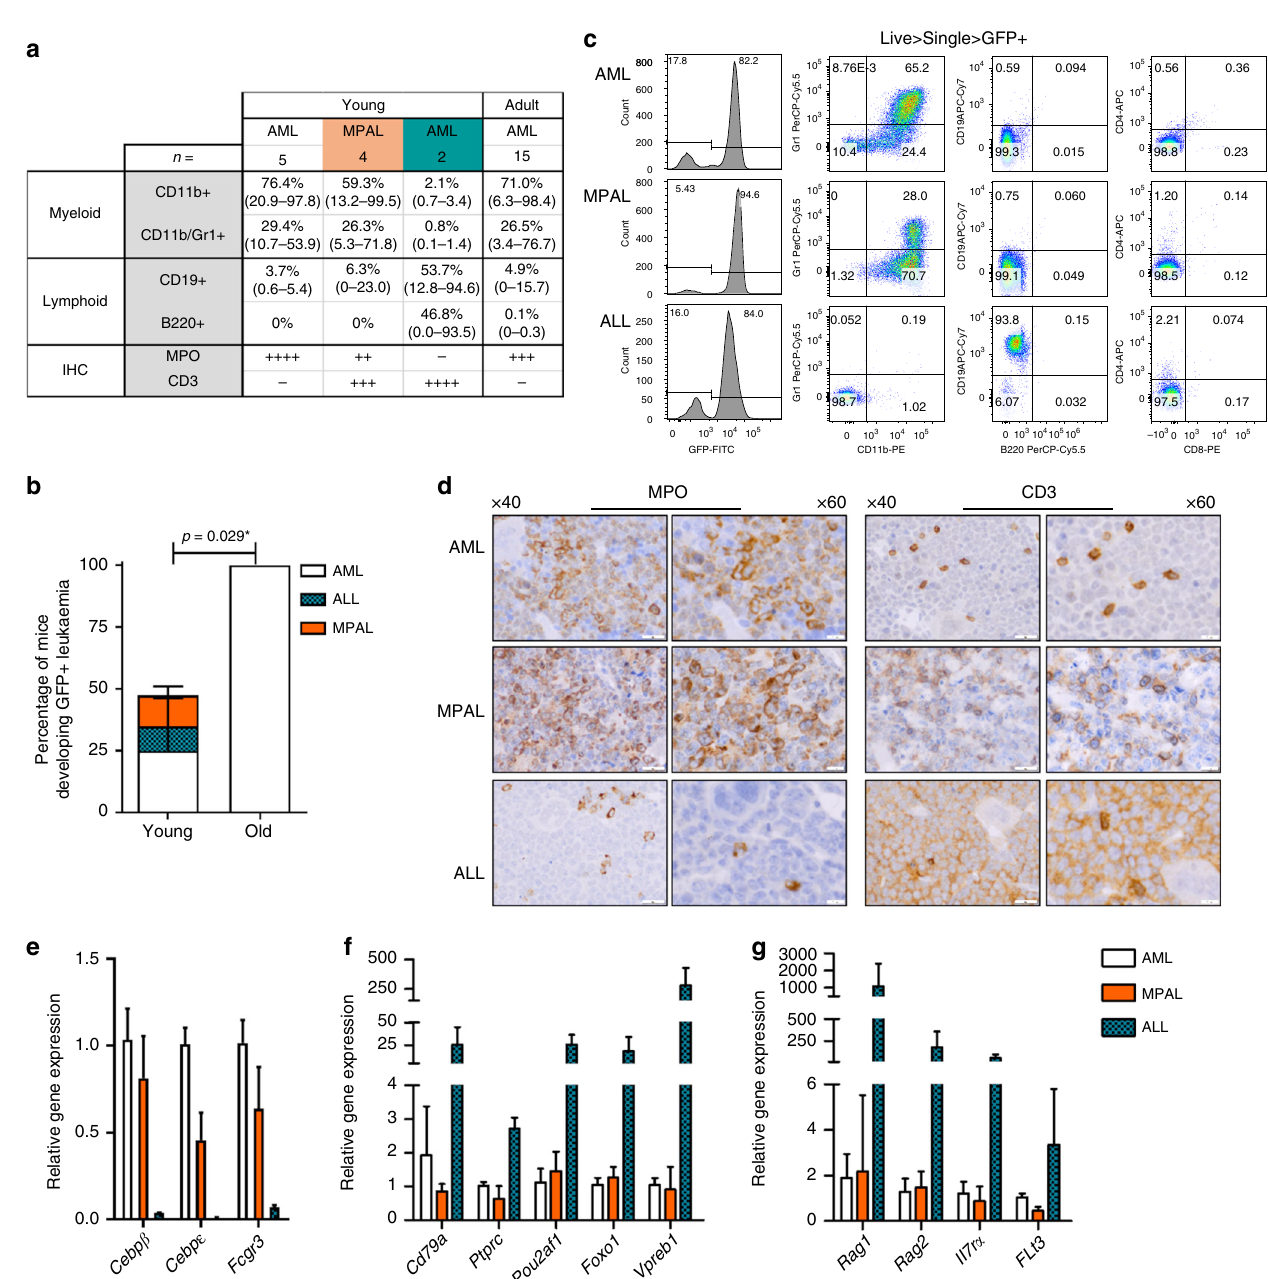
Fig. 3 Different leukaemia lineage phenotypes due to age of cell of origin. a Summary for the outcome for young or adult mice developing NH9 + leukaemia. Average expression of CD11b, CD11b/Gr-1, CD19 and B220 in GFP + BM cells is shown with expression range. For IHC ‘ − ‘ denotes neoplastic cells are negative for the marker, ‘ + ’ denotes 20%, ‘ ++ ’ 20 – 40%, ‘ +++ ’ 40 – 60% and ‘ ++++ ’ more than 60% positive expression in neoplastic cells. b Bar chart of lineage of all donor derived leukaemia showing data pooled into young (NH9 FL and NH9 3w ) ( n = 10) and adult (NH9 10w and NH9 >52w ) ( n = 15). Graphs depict mean + s.d. from two independent experiments. Signi fi cance determined by two-way ANOVA, * p < 0.05. c Representative fl ow cytometry plots from each disease phenotype AML (top row), MPAL (middle) and ALL (bottom). Flow cytometry plots depict CD11b, Gr-1, B220, CD19, CD8 and CD4 expression through GFP in the BM. d Representative ×40 and ×60 IHC images of sternal sections from each disease phenotype AML (top row), MPAL (middle) and ALL (bottom). Left two columns shows MPO and right 2 columns shows CD3. Positive cells exhibit brown cytoplasmic staining. Black scale bar represents 20 µ m for ×40 images and 500 µ m for ×60 images. Relative gene expression of e myeloid f B-lymphoid and g T-lymphoid genes in AML ( n = 3), MPAL ( n = 4) and ALL ( n = 2) generated in vivo from young LSKs transformed with NH9. Graphs depict mean LFC +